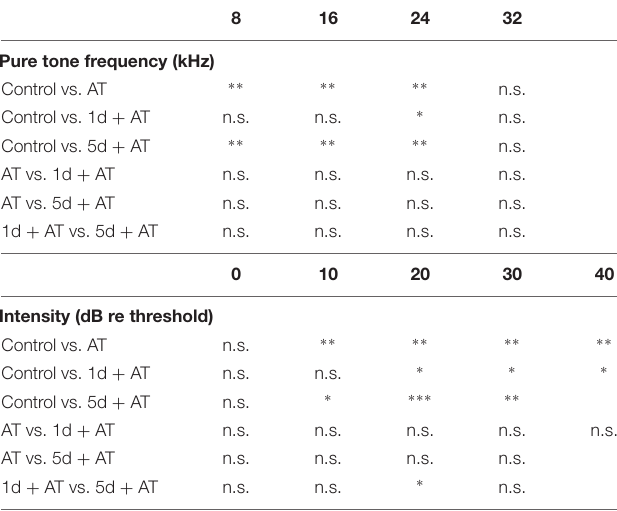
TABLE 2 | Post hoc comparisons (Student’s t -tests with Bonferroni adjustment) of ABR threshold shift for pure tone stimuli, ABR wave I amplitude evoked by noise burst stimuli at